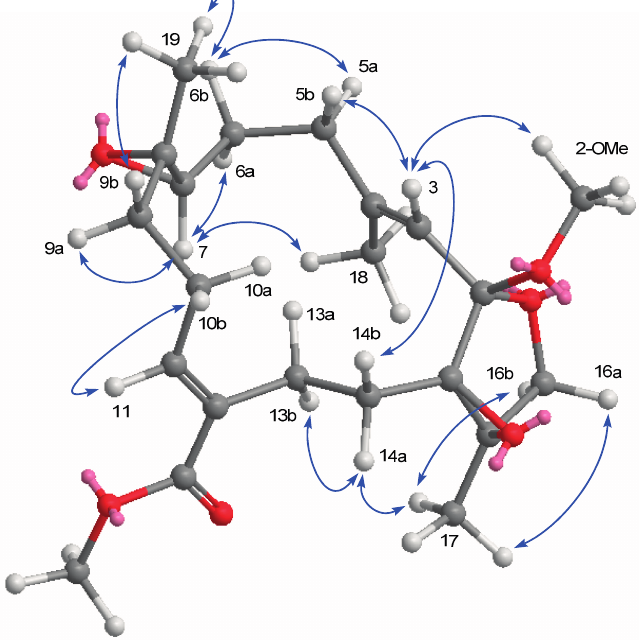
Figure 3. Selected NOESY correlations and computer-generated perspective model using MM2 force field calculations for 1